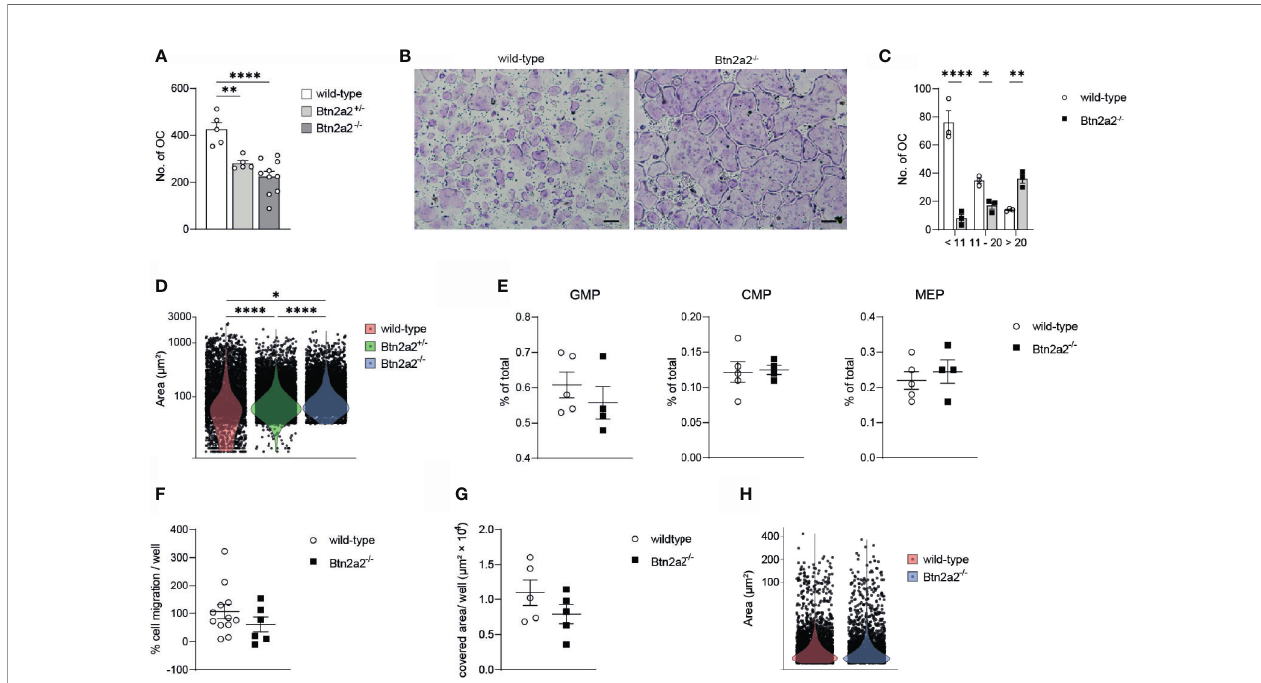
FIGURE 3 | Loss of Btn22 leds to reduced numbers of bone degrading osteoclasts. (A) quanti fi cation of the number of multinucleated TRAP+ osteoclasts from Wild-type, Btn2a2+/- and Btn2a2-/-mice after osteoclast assay. (B) Trap staining of Wild-type and Btn2a2-/- osteoclasts at day 5 of osteoclast assay and (C) quanti fi cation of the number of multinucleated TRAP+ osteoclasts by their number of nuclei. (D) violin plots displaying area of multinucleated TRAP+ osteoclasts at day 5 of osteoclast assay of wild-type Btn2a2+/- and Btn2a2-/- mice with each dot representing one osteoclast. (E) Flow cytometric analysis of bone marrow progenitor cells of wild-type and Btn2a2-/- mice. (F) OCP migration abilityof wild-type and Btn2a2-/- OCPs was assessed in vitro. Quanti fi cation of migrated cells was performed with images captured after 24 hours. Data are representative of two independent experiments, with 3 mice per group. (G) Analysis of resorption acitvity of Btn2a2-/- and their wild-type liltermates after 5 days of culture. (H) Resorbed area per osteoclast. Data are representative of two independent experiments, with 3-4 mice per group (B, C, E – G) or represent two pooled experiments (A, D, H) . Signi fi cance was assessed using one-way (A) or two-way ANOVA (C) and Bonferroni's post-hoc test or using two-tailed Students t-test. (D) Signi fi ance was assessed using Krusaii-Wallis test and pairwise comparisons using Wilcoxon rank sum test with Bonferroni's p value adjustments. (B) Scale bar indicates 200 m m. Data are shown as means t SEM. *P < 0.05; **P < 0.01; ****P <